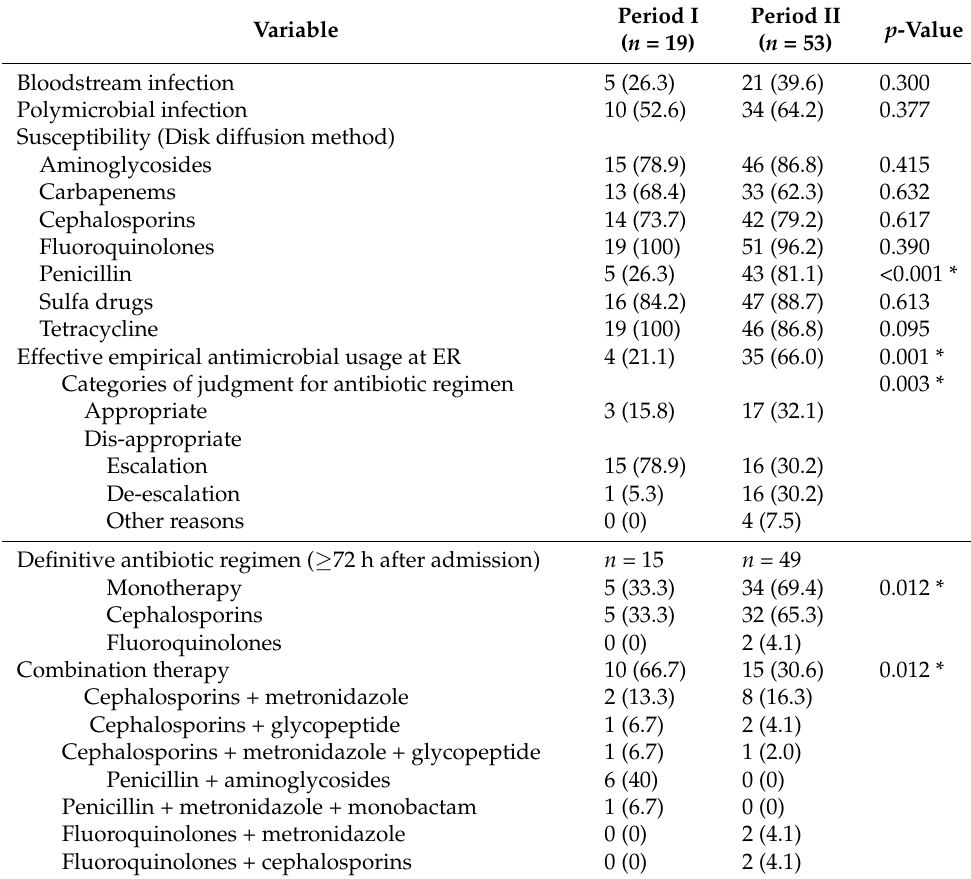
Table 3. Microbiological results and judgment for antimicrobial agents for 72 patients with Aeromonas NF between periods I and